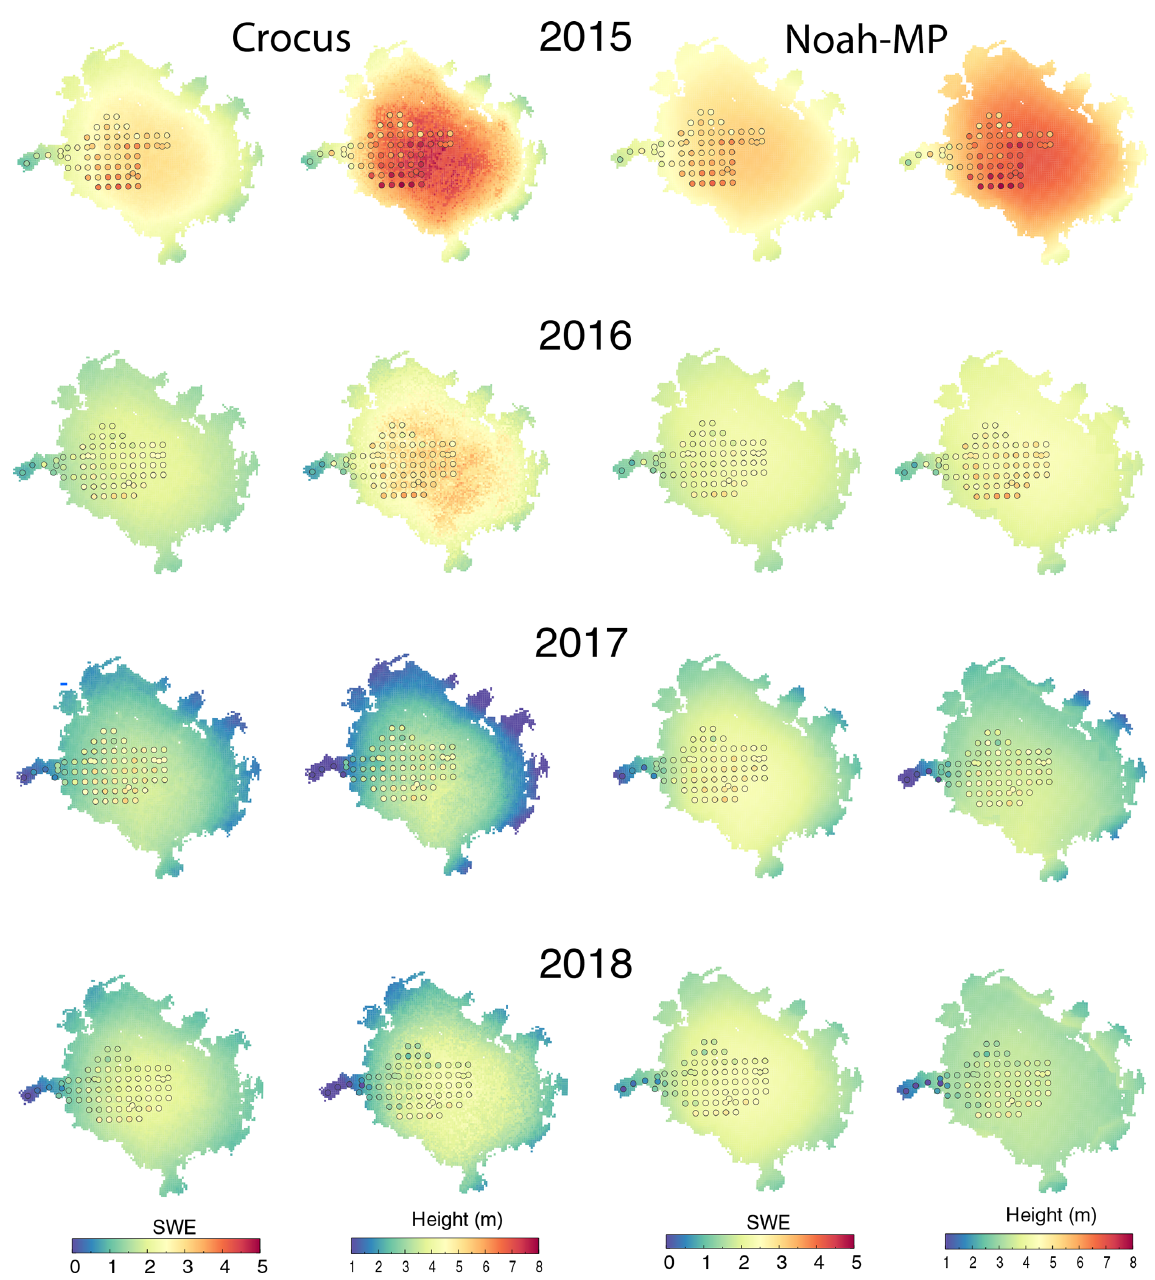
Figure 10. Mass balance at Rembesdalskåka. The two leftmost columns show the winter mass balance and accumulated snow height across Hardangerjøkulen as modeled with Crocus. Colored circles are observations from NVE. The two rightmost panels are the same as the two leftmost panels but as modeled with